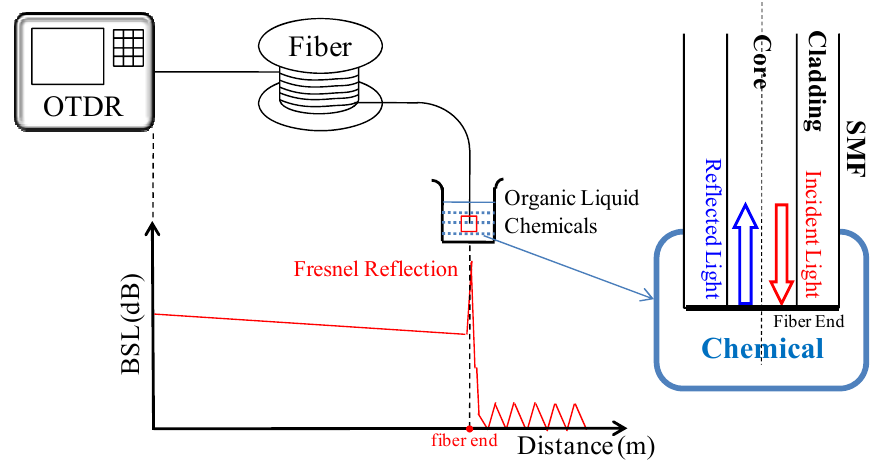
Figure 2. Experimental setup for RI measurement of organic liquid chemical by using OTDR-based fiber sensor head. The below schematic is the OTRD trace. The terminal facet of SMF is employed to serve as the sensing head and inserts in organic liquid chemical for RI detection, as shown in insert.